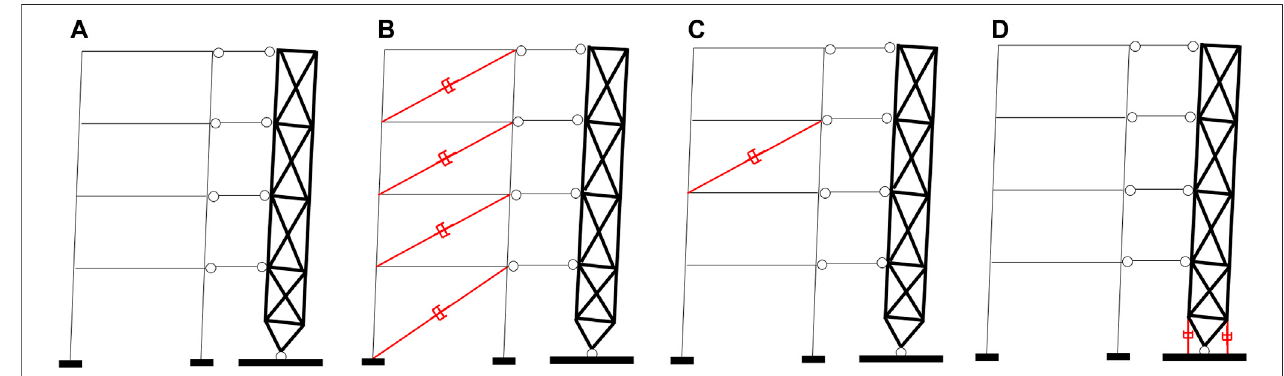
FIGURE 1 | Different con fi gurations of frames connected to an external strongback: (A) bare frame; (B) SPD system; (C) IS system; (D) DT system.